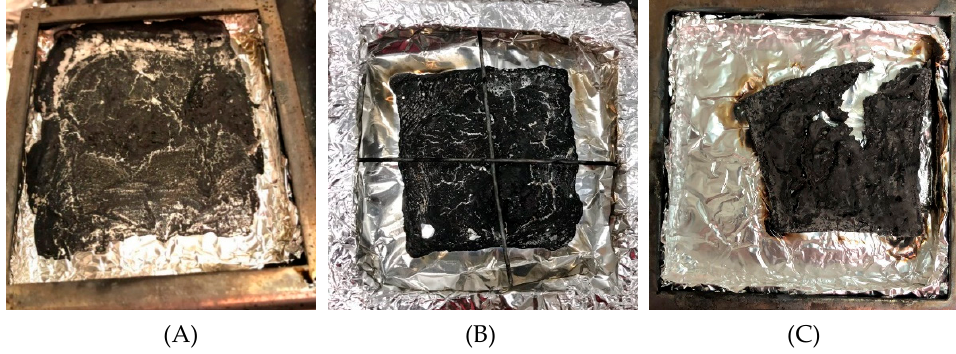
Figure 4. Images of aerogel samples after cone calorimetry test. ( A ) P 5 ; ( B ) P 5 /S 0.01 ; ( C ) P 5 /S 0.5 . To better understand the catalytic function of NaOH in PVA aerogel during combus- tion, the residues were studied using Raman spectroscopy (Figure 5). The spectra of chars